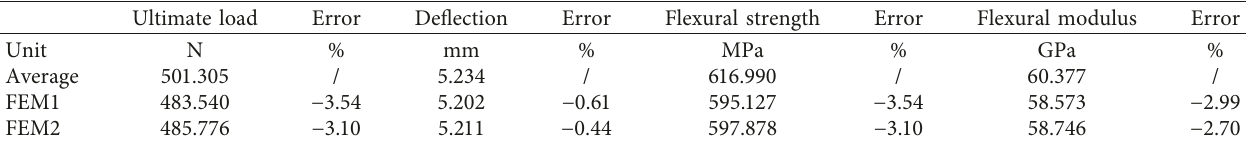
Table 3: Comparison of mechanical properties between simulation and experiments.